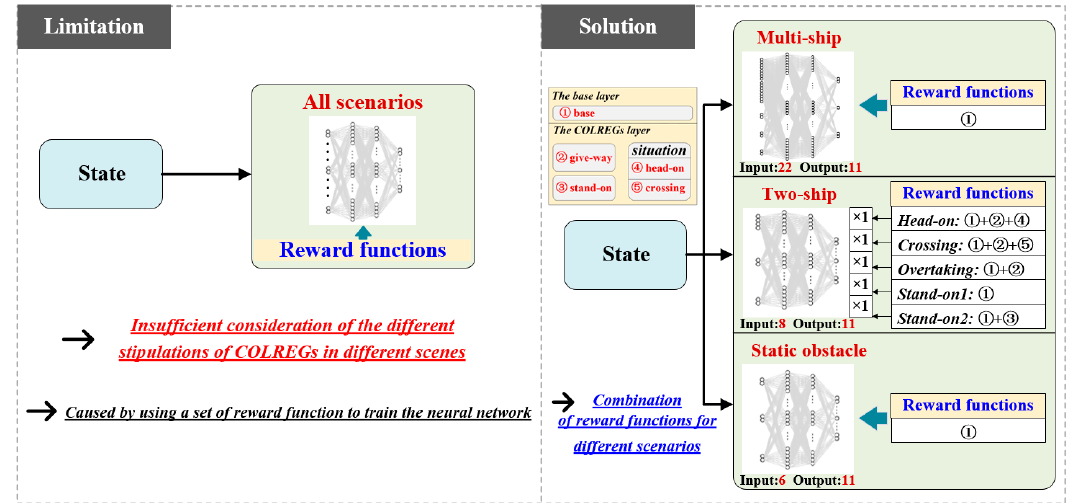
Figure 8. Network construction and combination of reward functions in different scenarios.